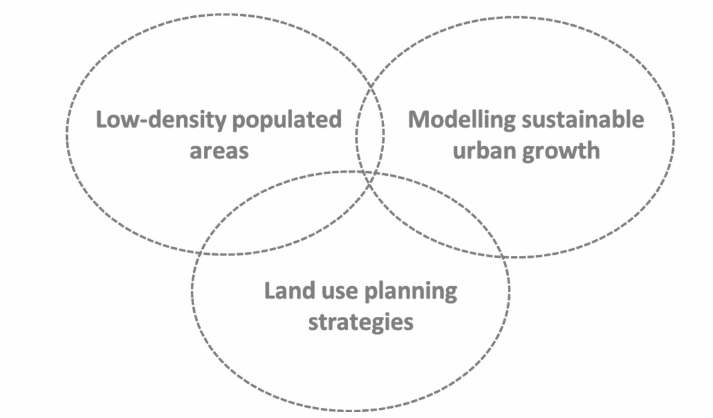
Figure 1. Coupled analysis: low-density populated areas, modelling sustainable urban growth, and land-use planning